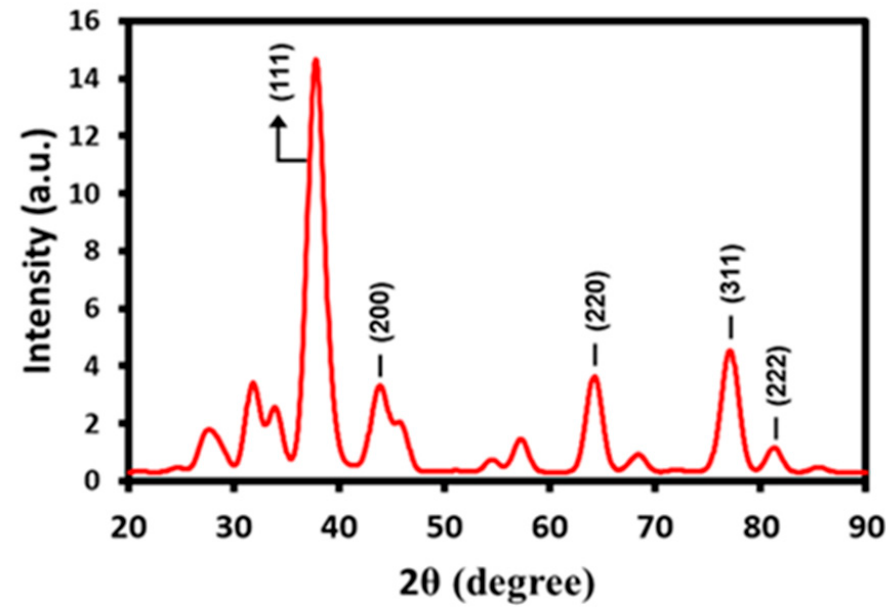
Figure 3. XRD pattern of prepared AgNPs-G indicated by presence of face-centered cubic ( fcc ) structure.